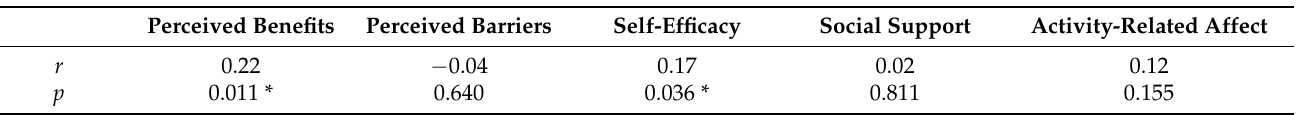
Table 2. Pearson’s correlation analysis between participation in community-based health promotion activities and the Health Promotion Questionnaire with all